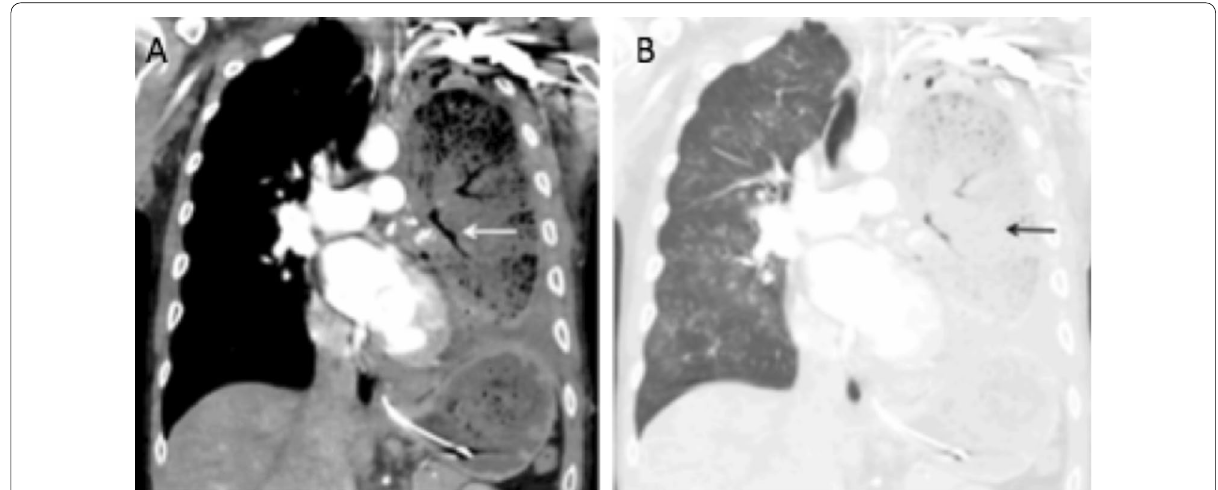
Fig. 12 Lobar torsion. Coronal CT images ( A : mediastinal window, B parenchymal window) showing a left lower lobar torsion after left upper lobectomy. A CT shows the torsion of the pedicle (white arrow) and the ascent of the left lower lobe. B We notice the condensation of the remaining lobe (black